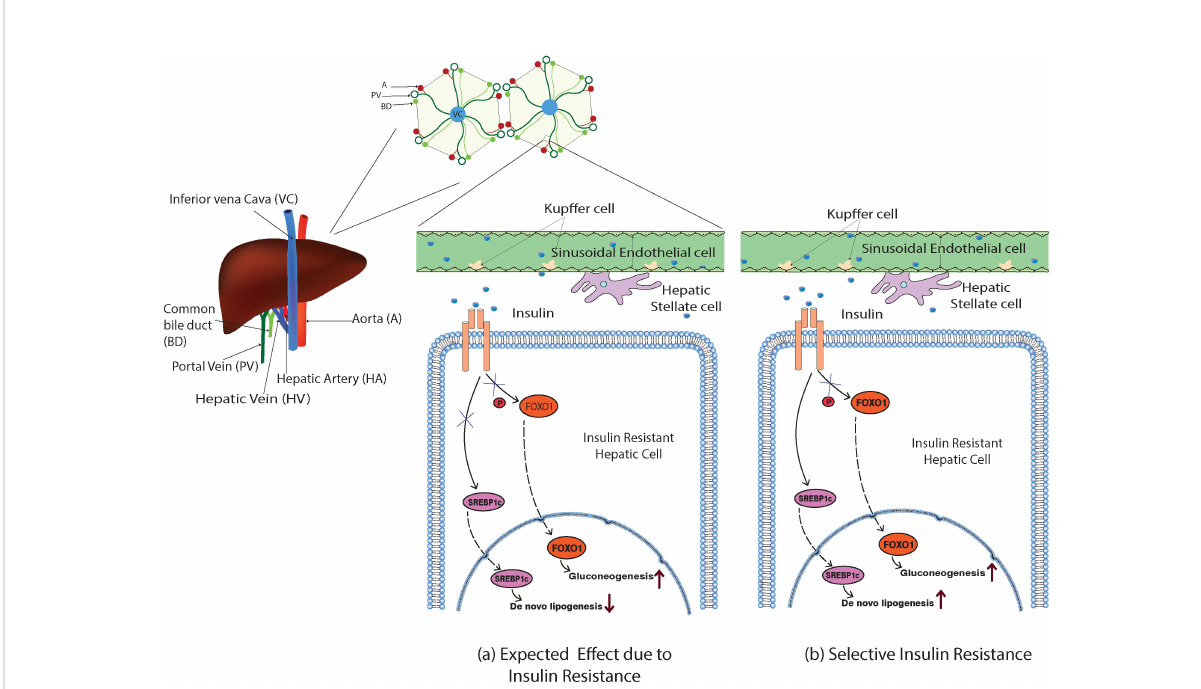
FIGURE 2 Model illustration of the expected and the selective action of insulin in the insulin-resistant hepatic cells. (A) Impaired insulin action would inhibit the phosphorylation of FOXO-1, inducing its nuclear translocation and promoting the gluconeogenesis, and expected to ablate the SREBP1c nuclear translocation as well suppressing de novo lipogenesis. (B) In selective hepatic insulin resistance, the SREBP1c nuclear translocation and de novo lipogenesis were unimpaired while FOXO-1-mediated gluconeogenesis